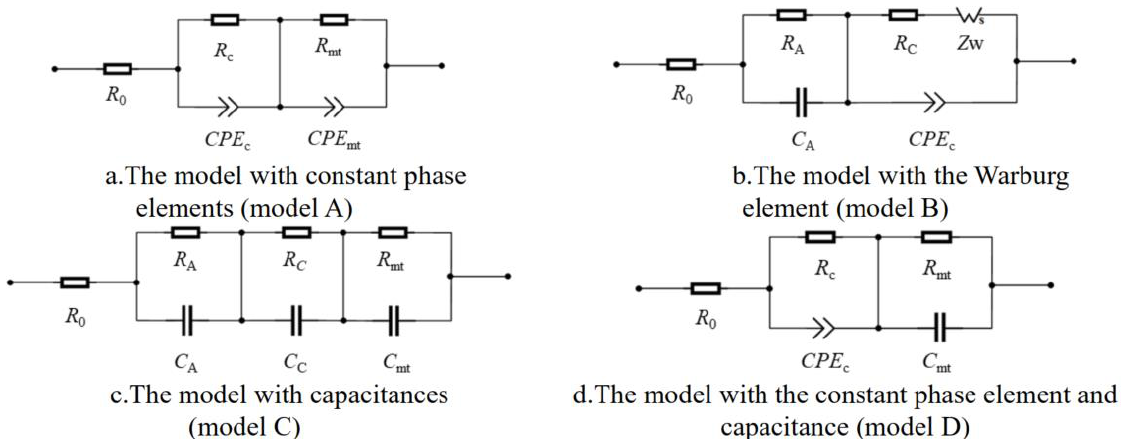
Figure 3. Typical equivalent circuit models used to fit the EIS data of PEMFCs: ( a ) the model with constant phase elements; ( b ) the model with the Warburg element; ( c ) the model with capacitances; ( d ) the model with the constant phase element and capacitance.